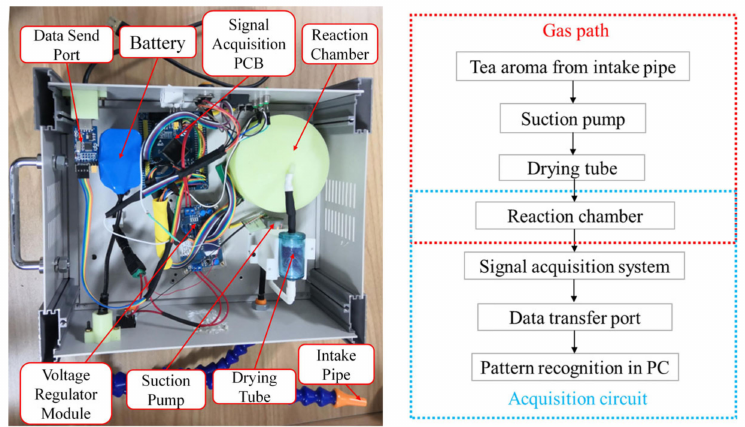
Figure 3. The internal structure and airflow of electronic nose